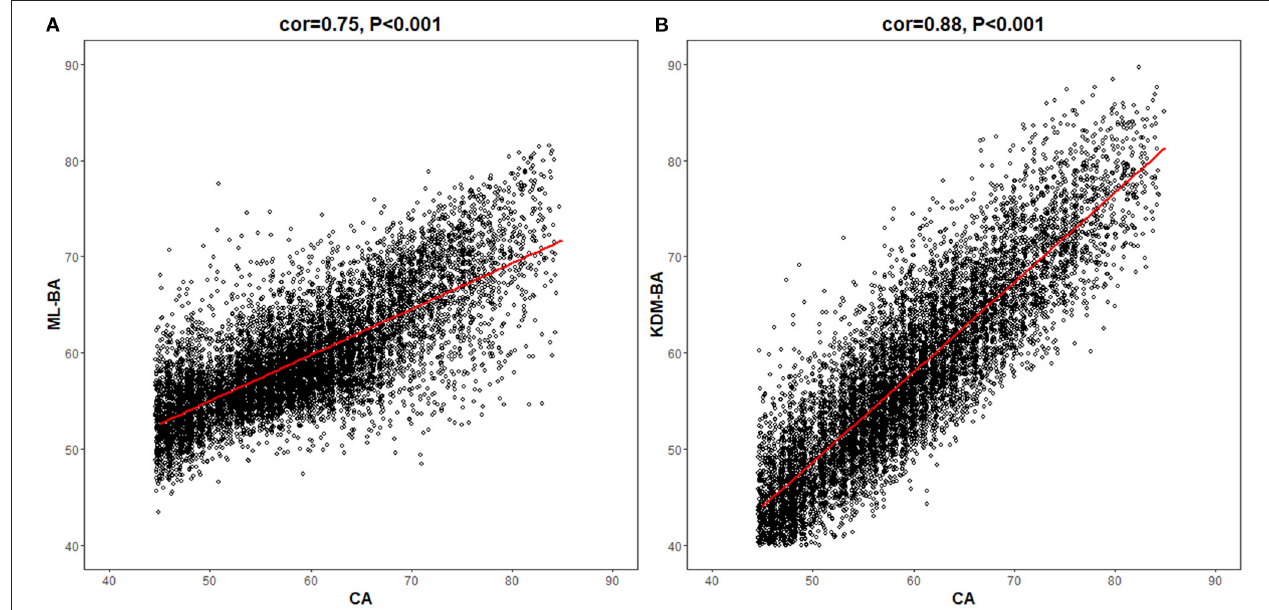
FIGURE 2 | Correlations of chronological age with machine learning method-biological age and Klemera and Doubal method-biological age. CA, chronological age; ML-BA, Machine Learning method-biological age; KDM-BA, Klemera and Doubal method-biological age. (A) and (B) show the correlation between CA and the two measures (ML-BA and KDM-BA), respectively.